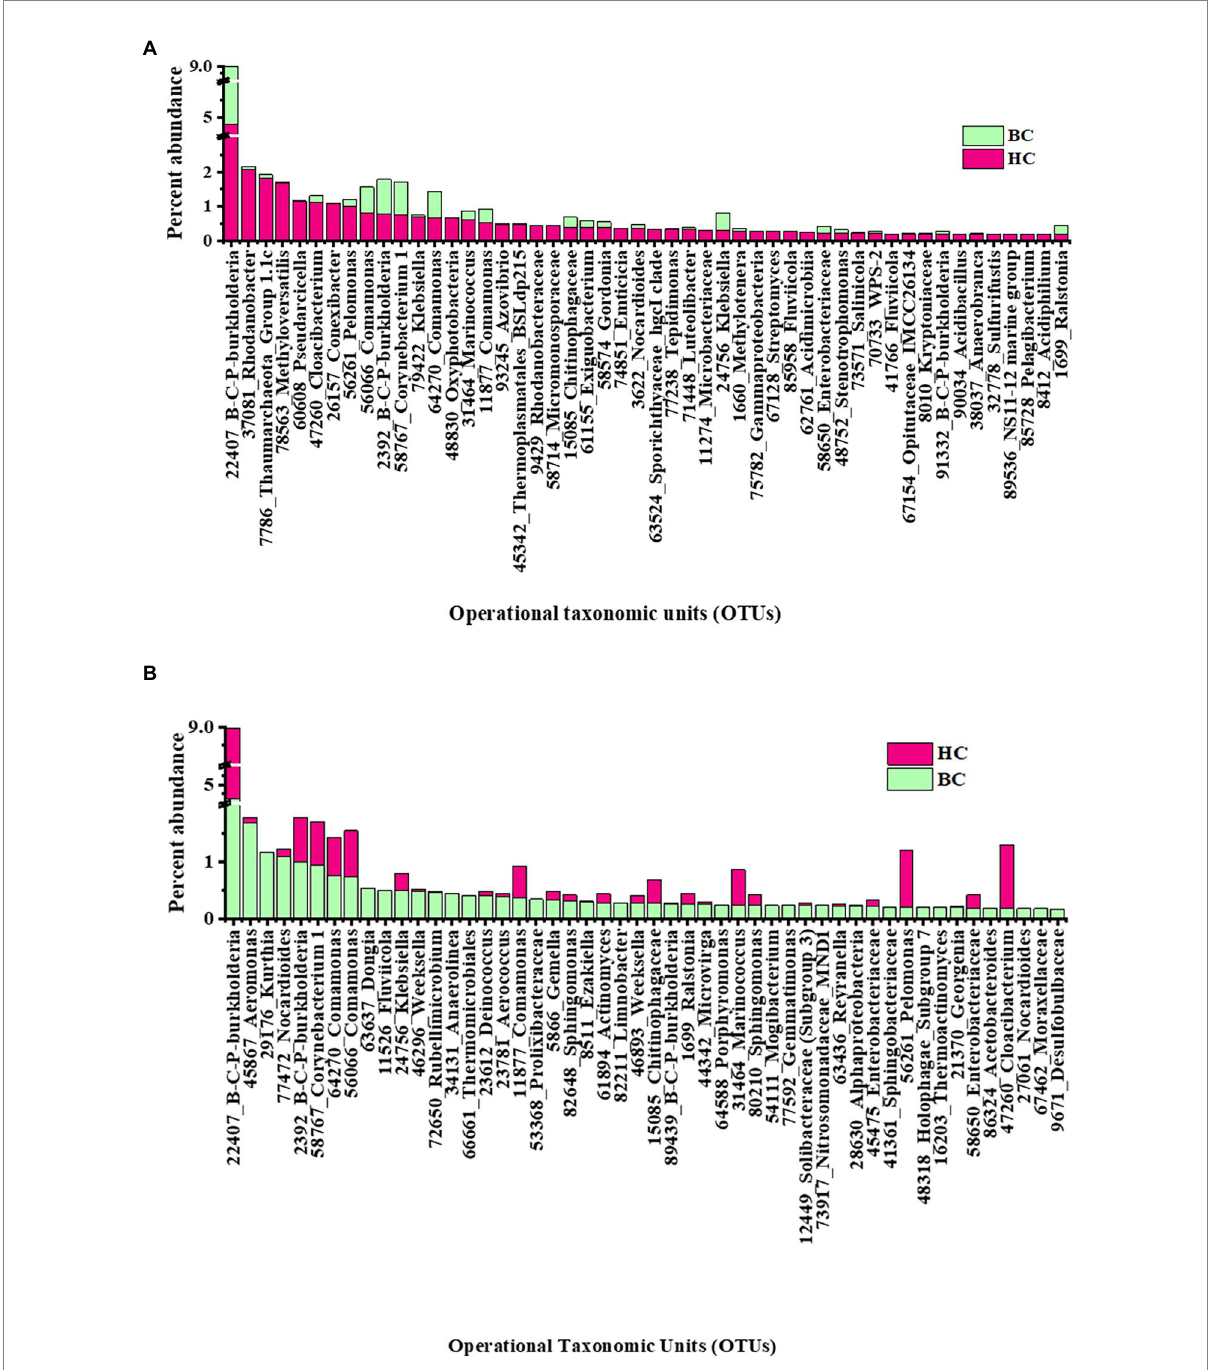
FIGURE 4 Rank abundance (based on relative percentage abundance) of top 50 OTUs detected in (A) HC and (B) BC enrichments. Burkholderia- Caballeronia-Paraburkholderia is designated as